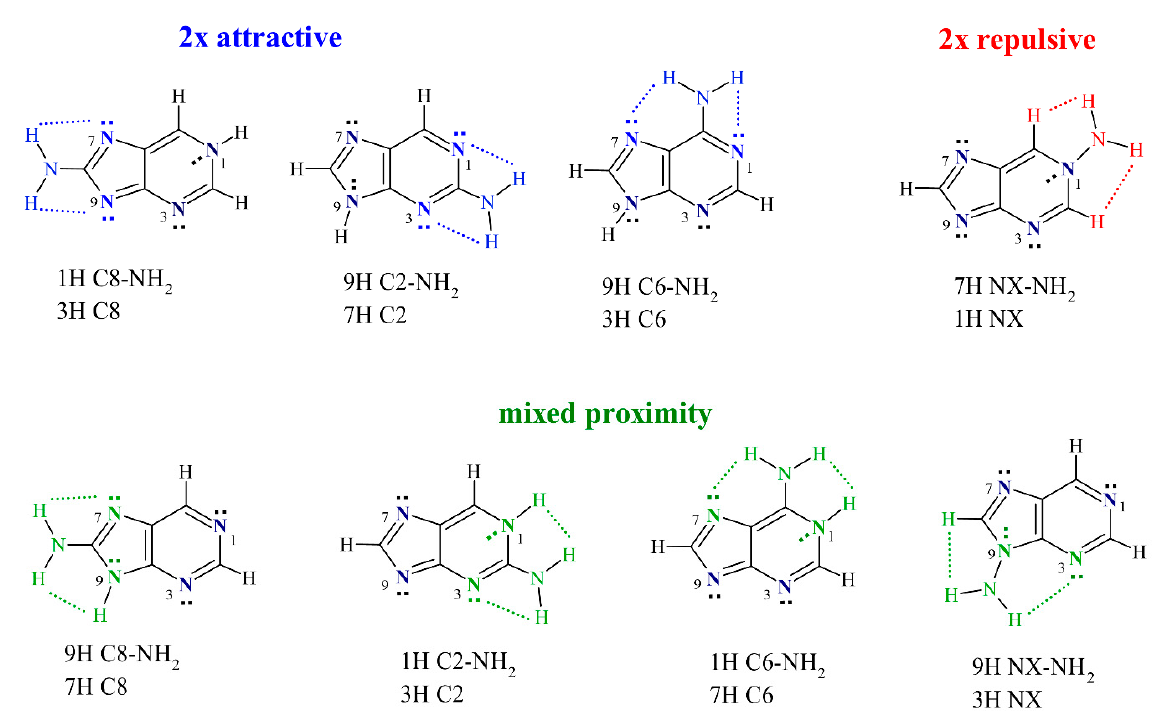
Scheme 2. Classification of the proximity interactions into three types used throughout this paper, along with the systems belonging to each type. The presented color-coding scheme is maintained in all